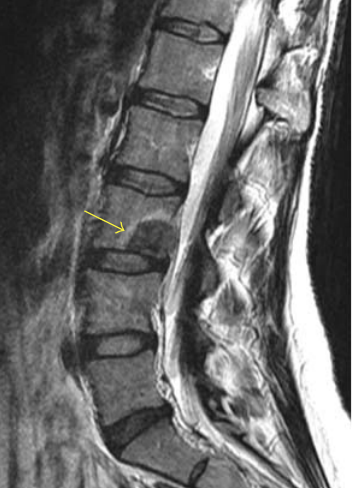
Figure 6: Sagittal T2-weighted MR image depicts the “halo sign” with a hypointense metastatic lesion and a surrounding hyperin- tense rim in the L3 vertebral body (yellow